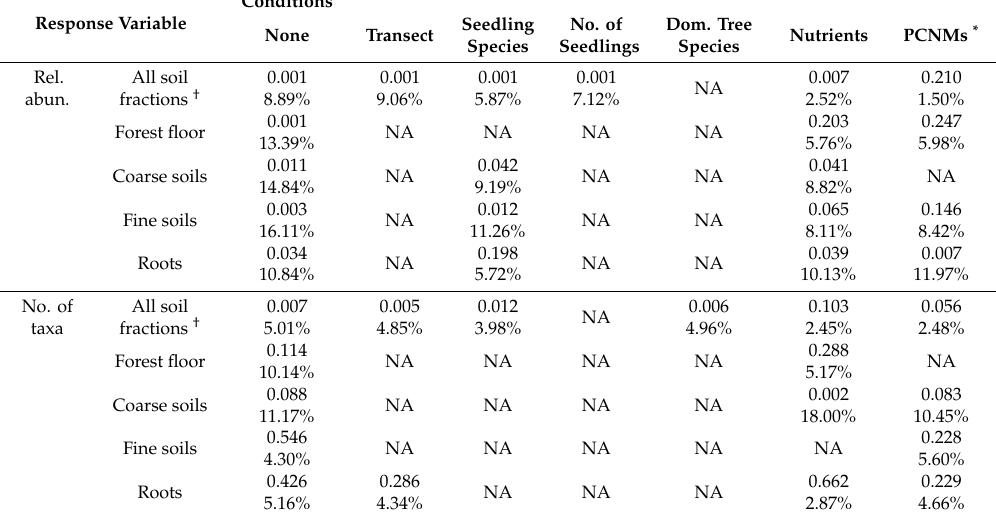
Table 4. Significance (expressed as p values) of distance from the forest edge in (partially) constrained ordinations (by redundancy analyses) of the relative abundance of fungal trophic groups or the number of taxa belonging to each trophic group in coarse soils, fine soils, the forest floor, roots, or all samples combined. Percent values represent the proportions of inertia explained by the constraints. Instances where confounding factors were not significant as constraints are designated with “NA” (not